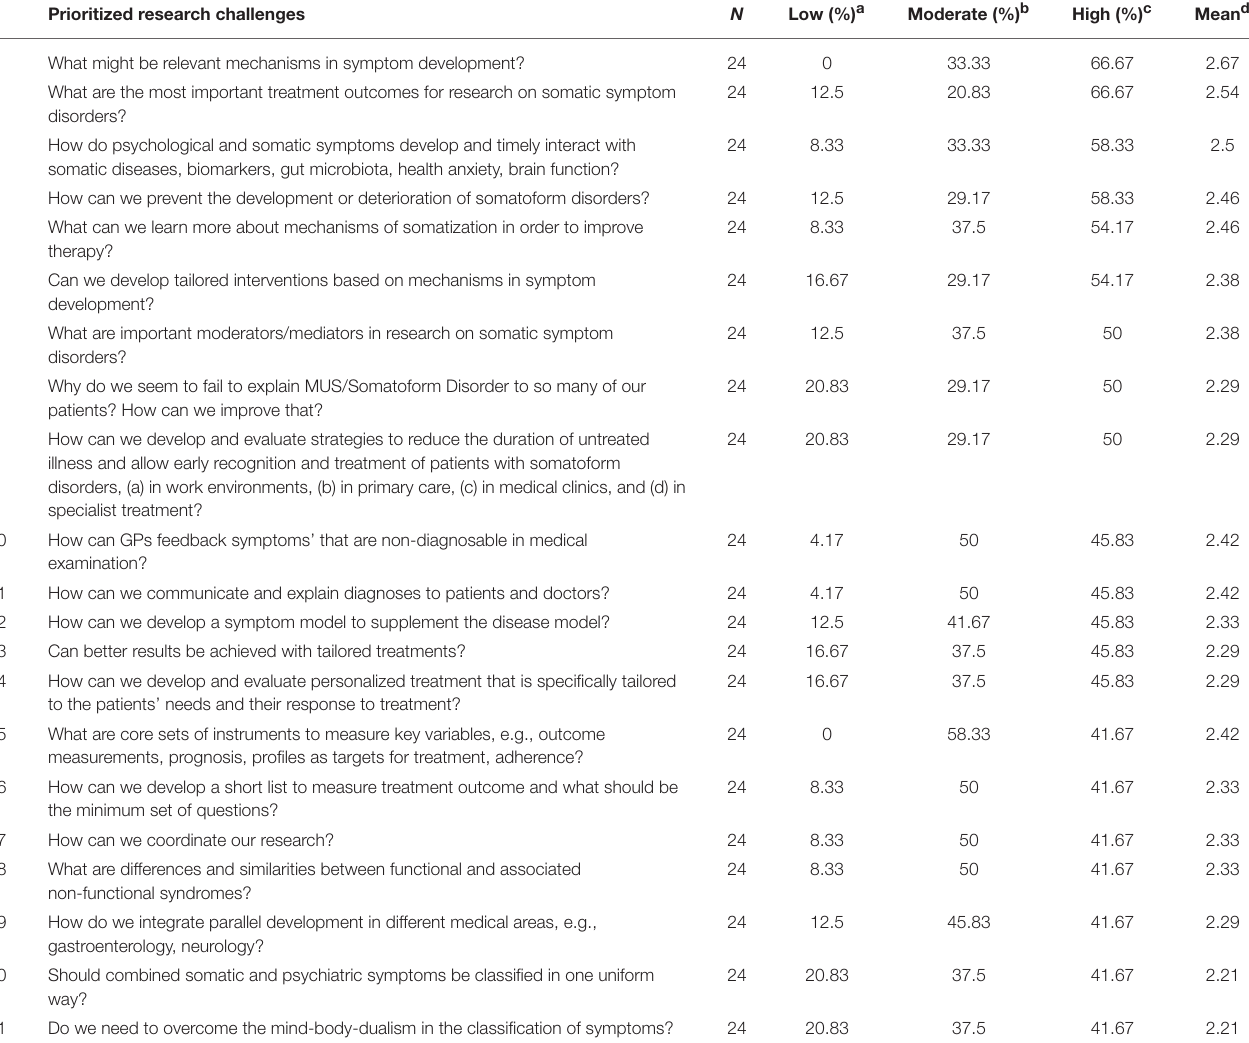
TABLE 1 | Prioritized research challenges as identified in the first wave. Prioritized research